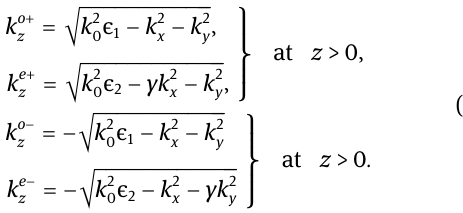
Figure1: (Coloronline)(a)Theinterfacebetweentwoanisotropicmaterials.Redlinesshowtheprofileofelectricfieldintensity.(b)Topviewof the interface. Red shaded regions show the propagation cones of DSWs. Angles φ DSWs. (c) Ordinary wave (solid black line) and extraordinary waves in anisotropic materials 1 and 2 (dashed and dotted lines) as well as DSW (redline)inreciprocalspace.(d)Azimuthalangledependenciesofpropagationconstant β ofDSWandtheabsolutevalueofimaginarypartsof z -projections of wavevectors of ordinary and extraordinary waves in anisotropic materials 1 and 2 with ε 1 (cid:1) 9 and ε 2 (cid:1) 16. Black dashed lines bound the φ -range of the existence of DSWs. (e) The penetration depth of DSW into upper and lower anisotropic media at φ (cid:1) 45 ° . (f) The ratio of electric fi eld intensities of ordinary and extraordinary waves which form DSW (blue line) and the ratio of coef fi cients C e / C o (red lines) as functions of anisotropy factor γ (cid:1) ε 2 / ε 1 . (g) Degree of circular polarization (DCP) of DSW at z (cid:1) 0 propagating at φ (cid:1) 45 ° as a function of anisotropyfactor γ .(h)DCPofDSWpropagatingat φ (cid:1) 45 ° asafunctionofcoordinate z at ε 2 / ε 1 (cid:1) 3.(i)Thickblacklinesdenotethelimitsofthe φ -range existence of DSWs as functions of anisotropy factor, φ angle dependence of the DCP of DSW. Colorscale is shown on the right. DSW, Dyakonov surface